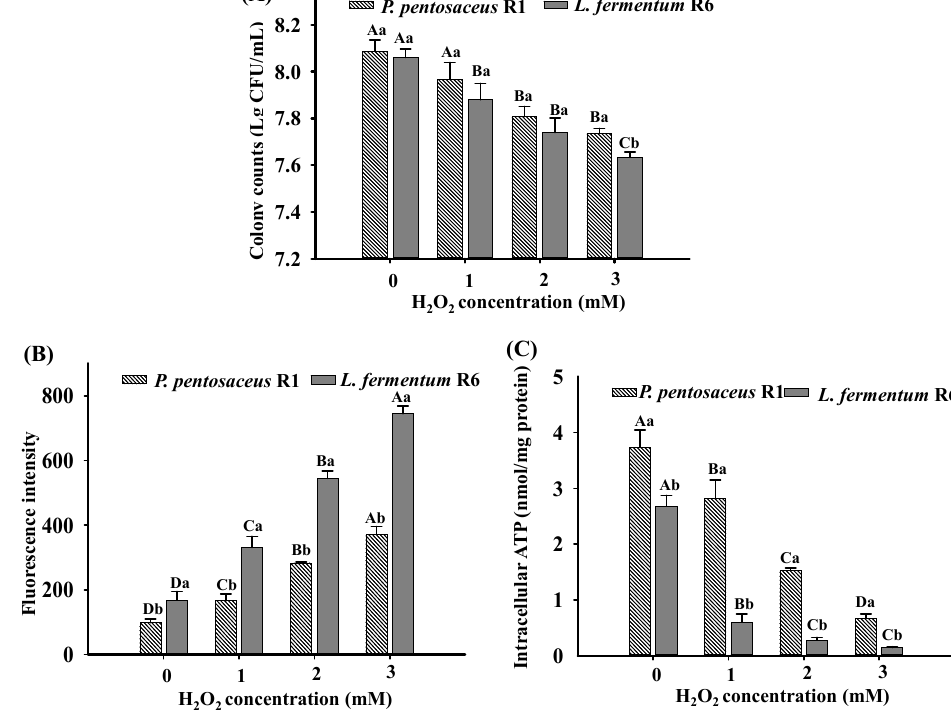
Figure 1. Changes in colony counts ( A ), intracellular reactive oxygen species (ROS) levels ( B ), and intracellular ATP concentrations ( C ) of Pediococcus pentosaceus R1 and Lactobacillus fermentum R6 incubated in MRS broth with different H 2 O 2 concentrations for 1 h. Different uppercase letters (A–D) denote statistical differences ( p < 0.05) within the same strain under different H 2 O 2 concentrations; different lowercase letters (a and b) denote statistical differences ( p < 0.05) for both strains within the same H 2 O 2 concentration.